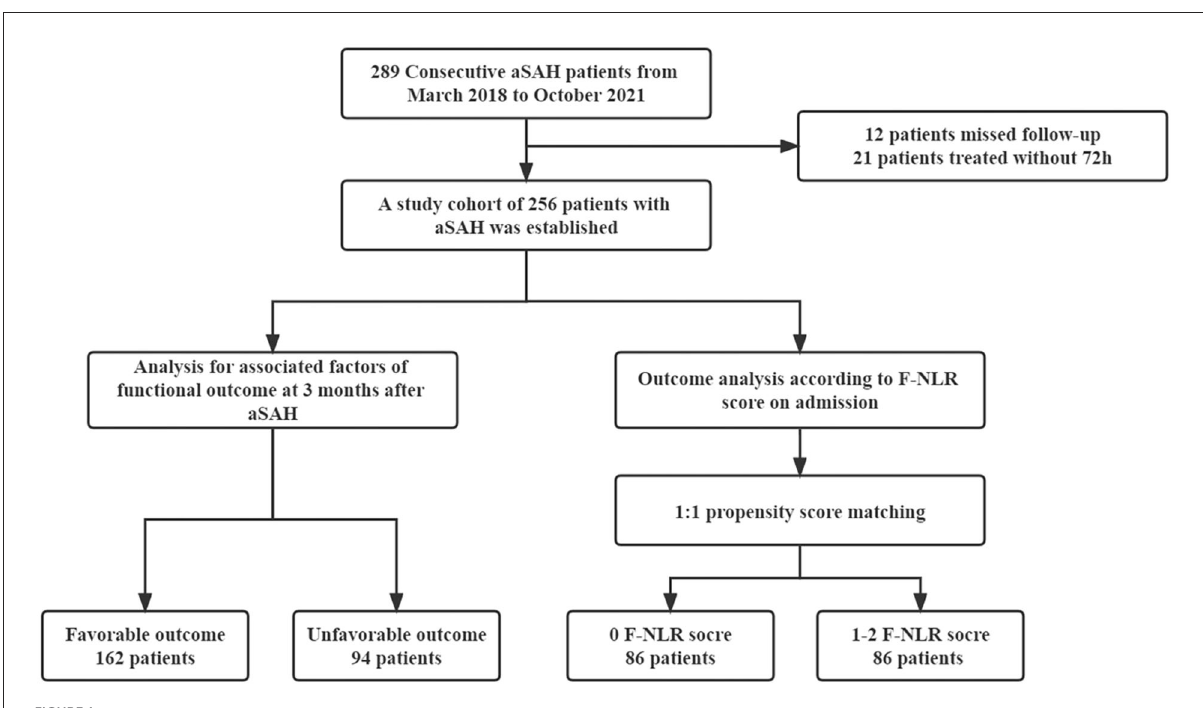
FIGURE1 Flowchart of study. aSAH, aneurismal subarachnoid hemorrhage; F, fibrinogen; NLR, neutrophil to lymphocyte ratio.